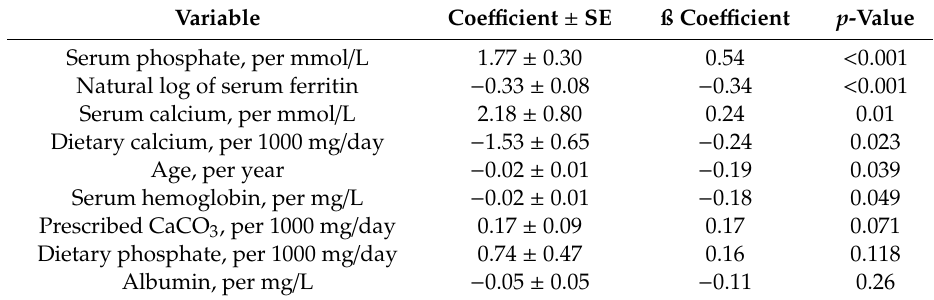
Table 7. Hand-built multivariable model to predict natural log of FGF23 (adjusted r 2 = 69%).